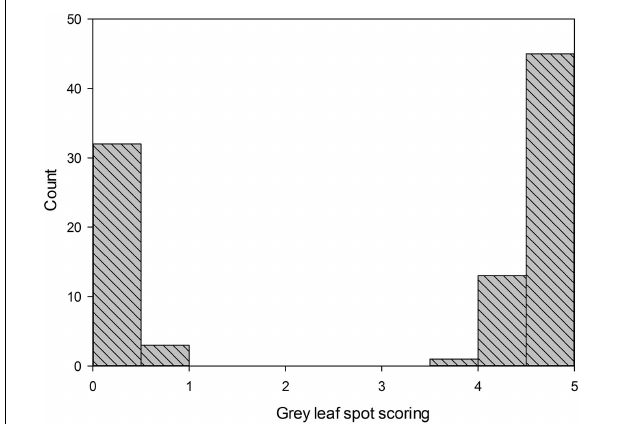
FIGURE 2 | Distribution of gray leaf spot scoring in F8 recombinant inbred lines (RIL 8 ) population. Line 83A:476 score was 0 (resistant), and wild-type P27255 was 4.65 (susceptible); n =